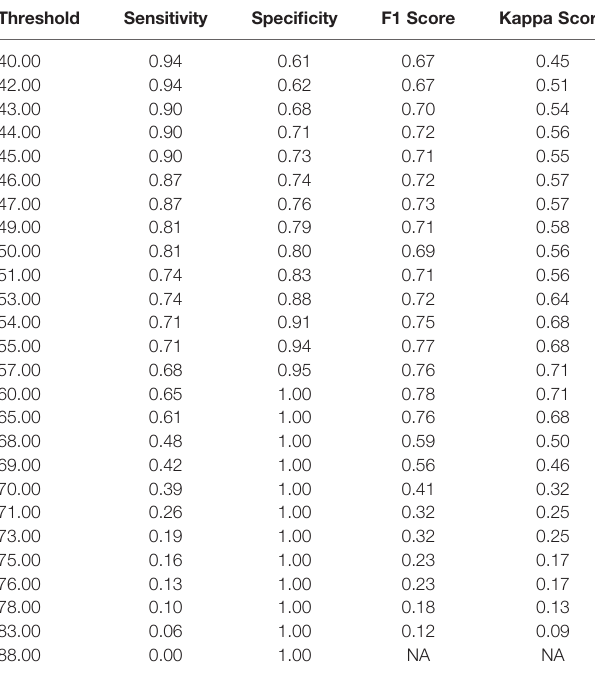
TABLE 3 | Performance on the internal test set. TABLE 4 | Performance on the extra test